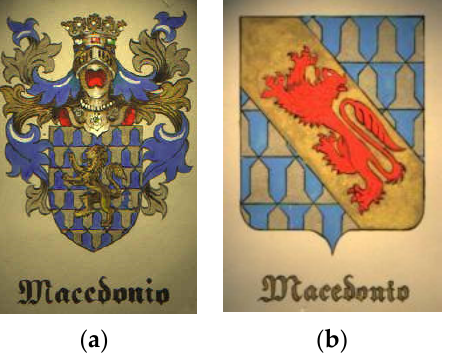
Figure 14. ( a ) CoA of the marquise of Oliveto, Naples. ( b ) CoA of the dukes of Campora, Naples. Since both views on the origins of the Macedonian and Bulgarian land coats of arms are not conclusive, there is a possibility of a third: two different sources with relatively similar blazons resulting in simplification and inverse coloring of both of the coats of arms. This would mean that it is quite possible that the Macedonian coat of arms was taken over by Capaccio, who took it from another older source. First of all, the coats of arms with a lion attributed to Alexander the Great should be taken into consideration. In many of the armorials, we find that the coat of arms of a country is presented as the coat of arms of the ruler of that country. Examples of this with Alexander the Great are found in Silbereisen: Chronicon Helvetiae from 1576. In it, a coat of arms is described as of the king and kingdom in the time of Alexander the Great (Figure 15). This in turn comes from Richental’s blazon for